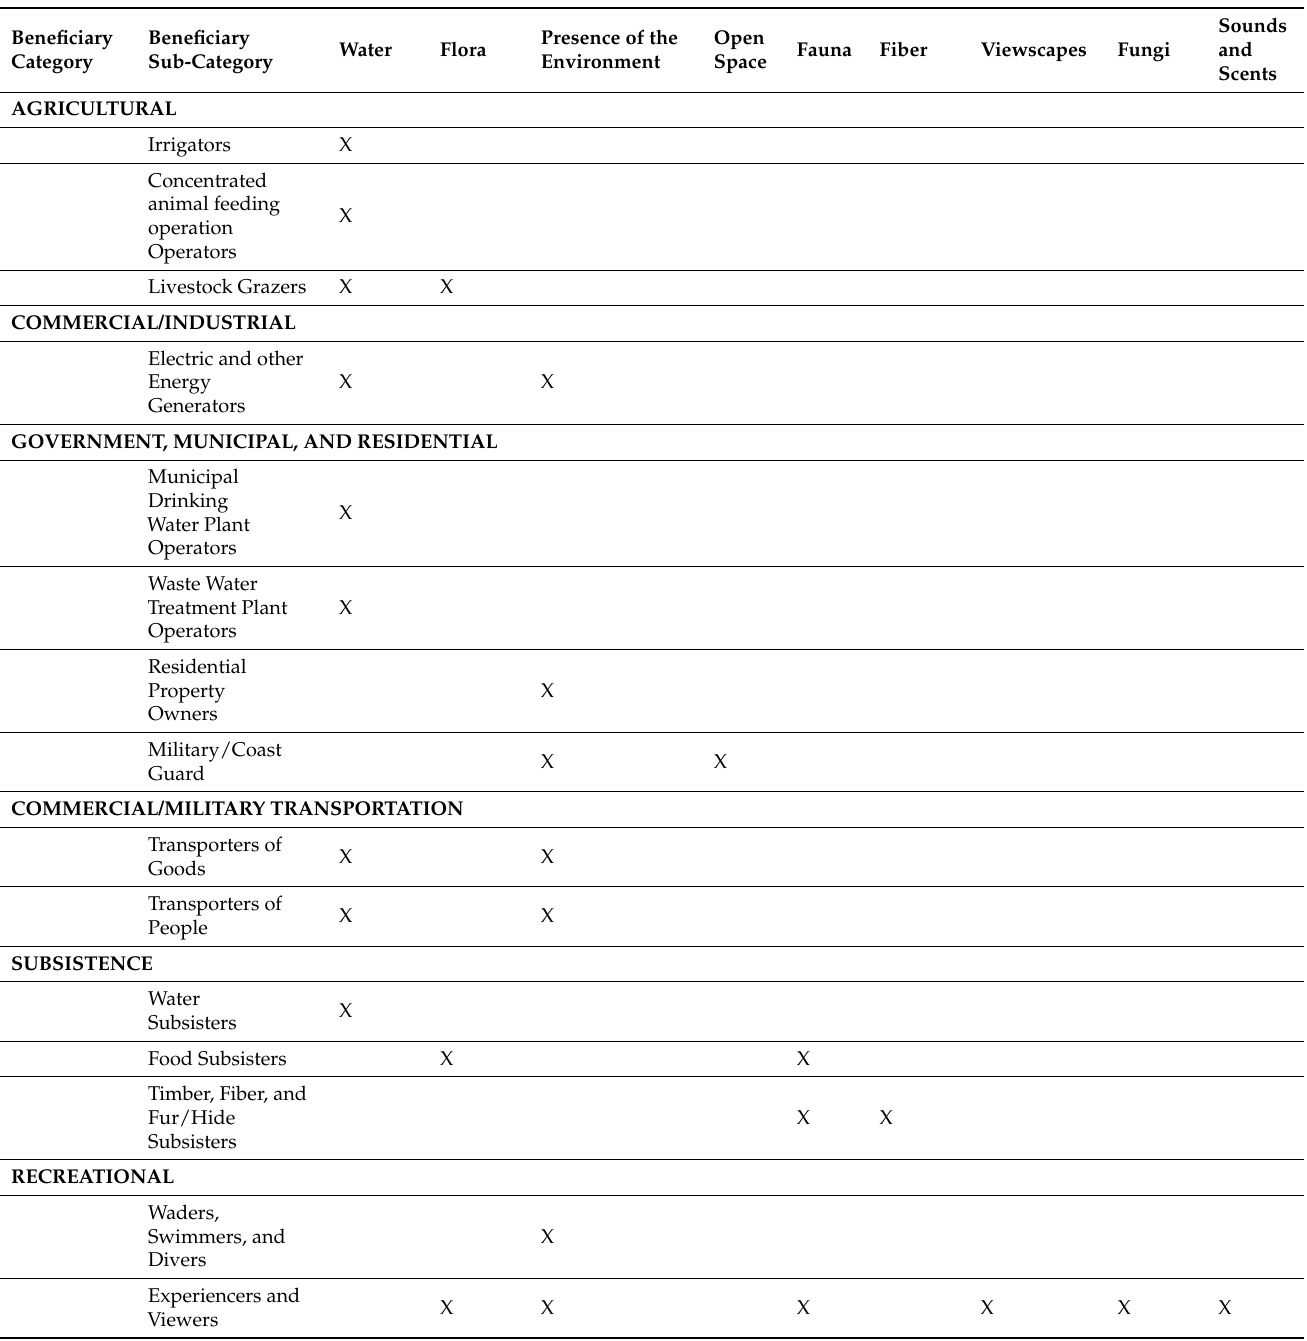
Table 2. Matrix B: matrix summary of beneficiary categories, beneficiary sub-categories, and ecosys- tem goods and services. Source: Adapted from the U.S. EPA. Final Ecosystem Goods and Services Classification System (FEGS-CS)